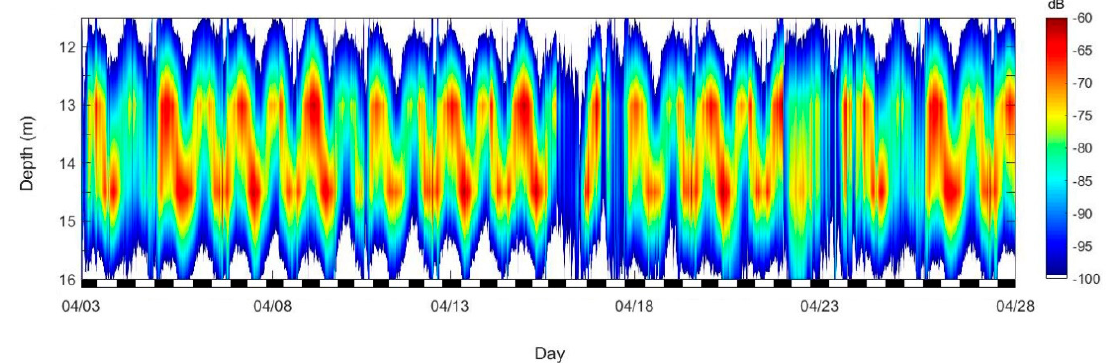
Figure 4. Extracted MVBS of moored ADCP data at 11.5–16 m. The black bar below the echogram indicated the night time while the white bar indicated the daylight time.